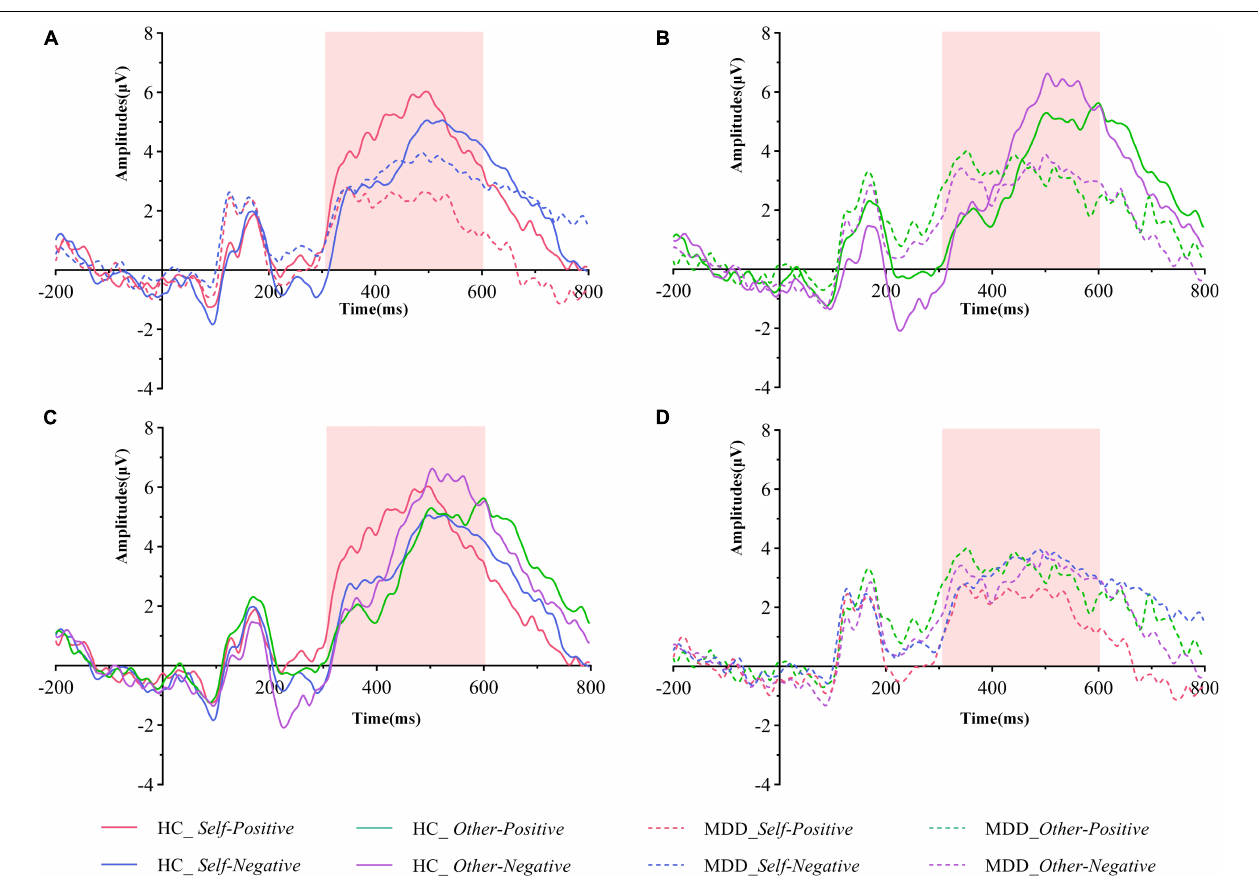
FIGURE 3 | Grand averaged ERPs of both groups under different conditions of the pooling electrodes site (averaged Cz, CPz, and Pz sites). (A) Grand averaged ERPs in the HC group (solid lines) and the MDD group (dashed lines) during the self-positive (red lines) and the self-negative (blue lines) conditions. (B) Grand averaged ERPs in the HC group (solid lines) and the MDD group (dashed lines) during the other positive (green lines) and the self-negative (purple lines) conditions. (C) Grand averaged ERPs in the HC group during the self-positive (red lines), the self-negative (blue lines), the other positive (green lines), and the self-negative (purple lines) conditions. (D) Grand averaged ERPs in the MDD group during the self-positive (red lines), the self-negative (blue lines), the other positive (green lines), and the self-negative (purple lines) conditions. The go-P3 time windows are marked with light pink shadow. MDD, major depressive disorder; HC, healthy control.